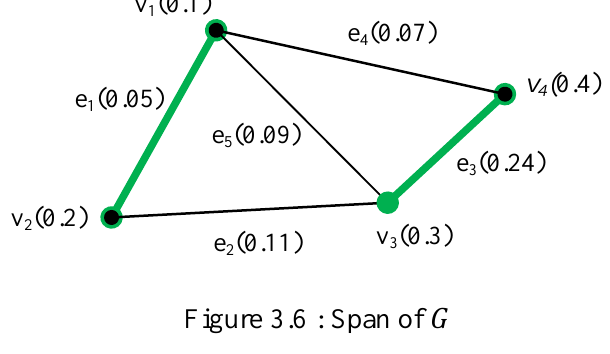
Figure 3.6 : Span of